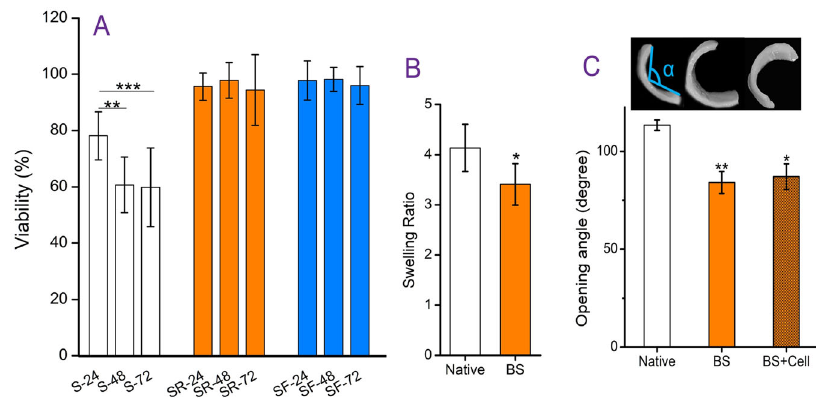
wet and dry conditions, and swelling ratio was calculated. C Measurement of the residual stress by opening angle test. The Native sample which is a fresh coronary artery tissue without any process. The BS sample is biological scaffold obtained from the same tissue. The BS + Cell sample is the BS after 3-day SMC cultivation.